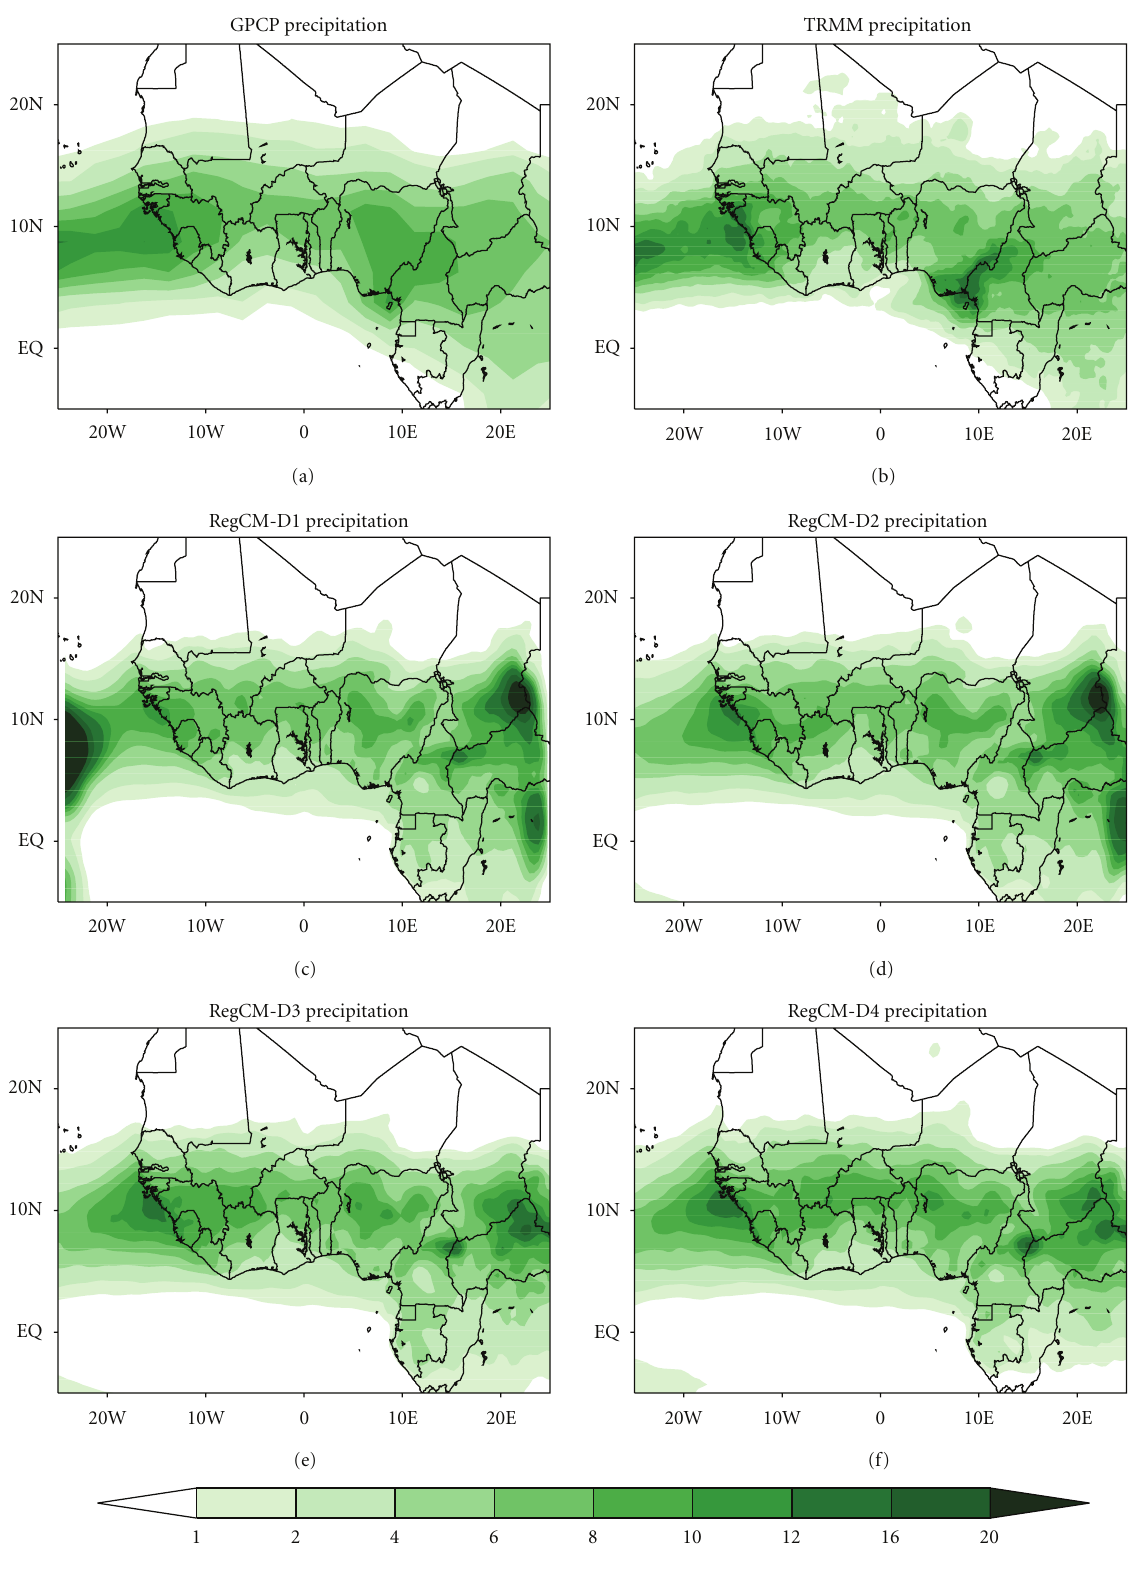
Figure 2: Mean JJA rainfall averaged for the period 2001–2005 from (a) GPCP, (b) TRMM, (c) RegCM-D1, (d) RegCM-D2, (e) RegCM-D3, and (f) RegCM-D4. Units are expressed in